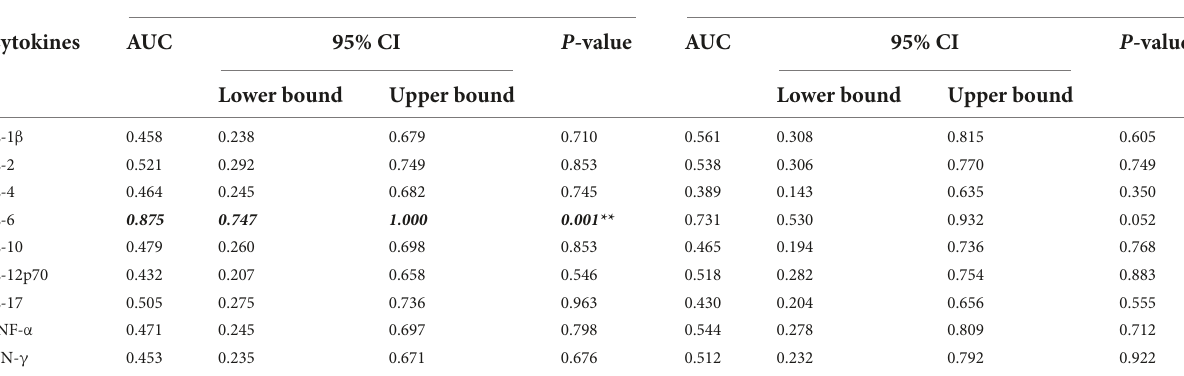
TABLE 7 Performance of cytokines in bronchoalveolar lavage fluid (BALF) for differentiating mild cases vs. moderate and severe cases across 28 cases. Mild vs. moderate + severe (12 vs. 16)* Mild + moderate vs. severe (19 vs.